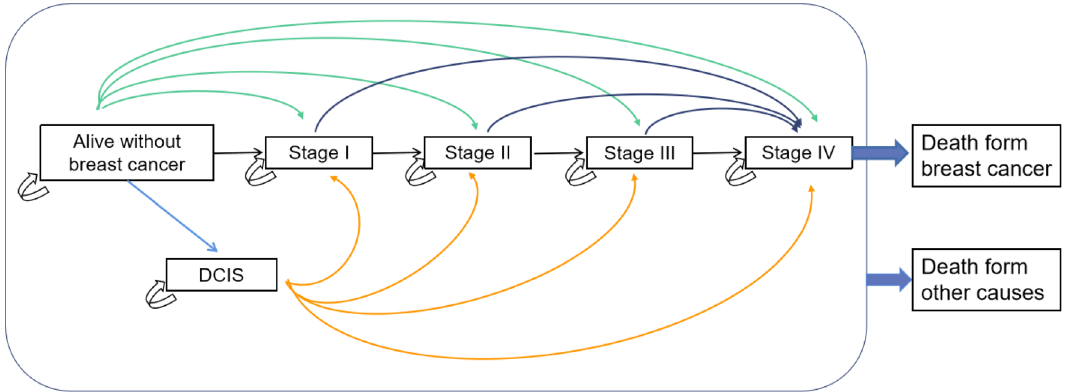
Figure 2. Natural history model for breast cancer